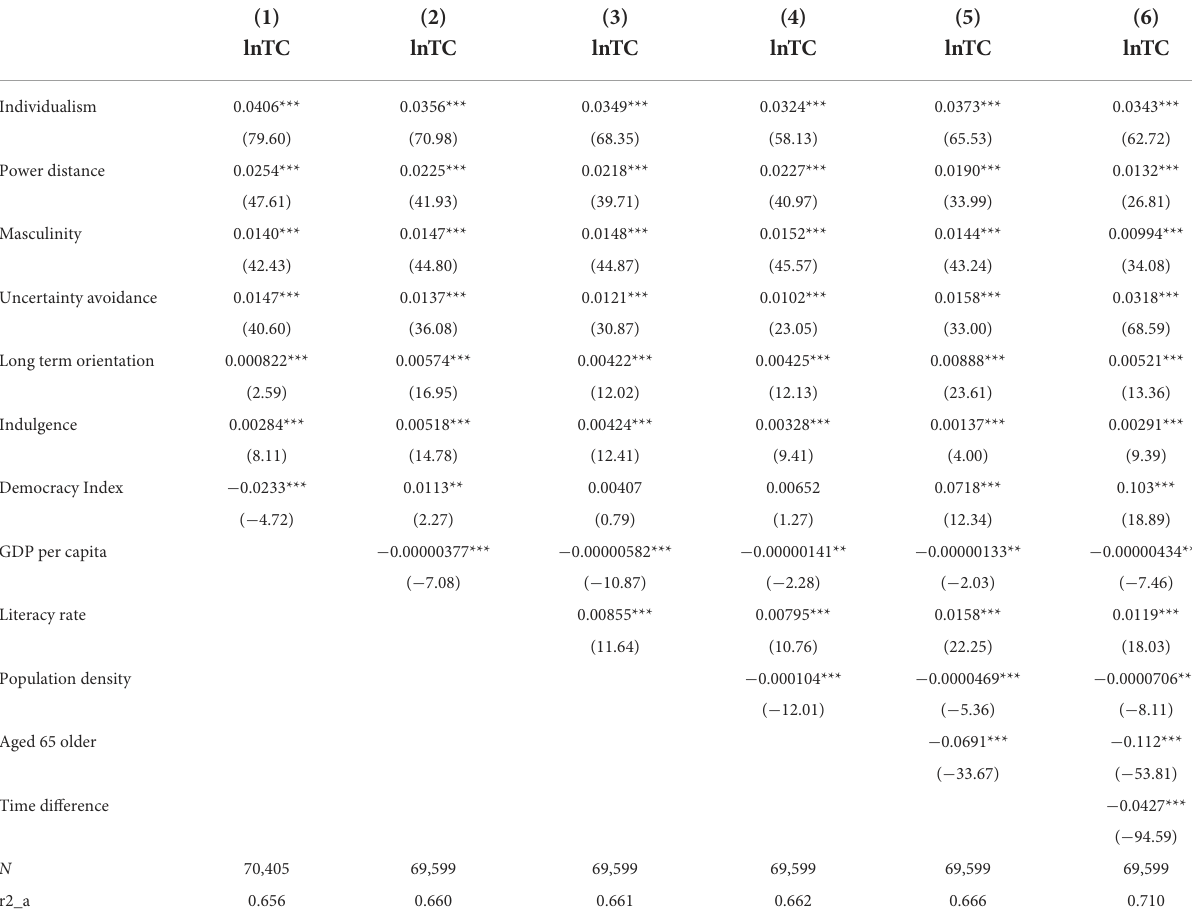
TABLE 2 Impact of 6 culture dimensions on total